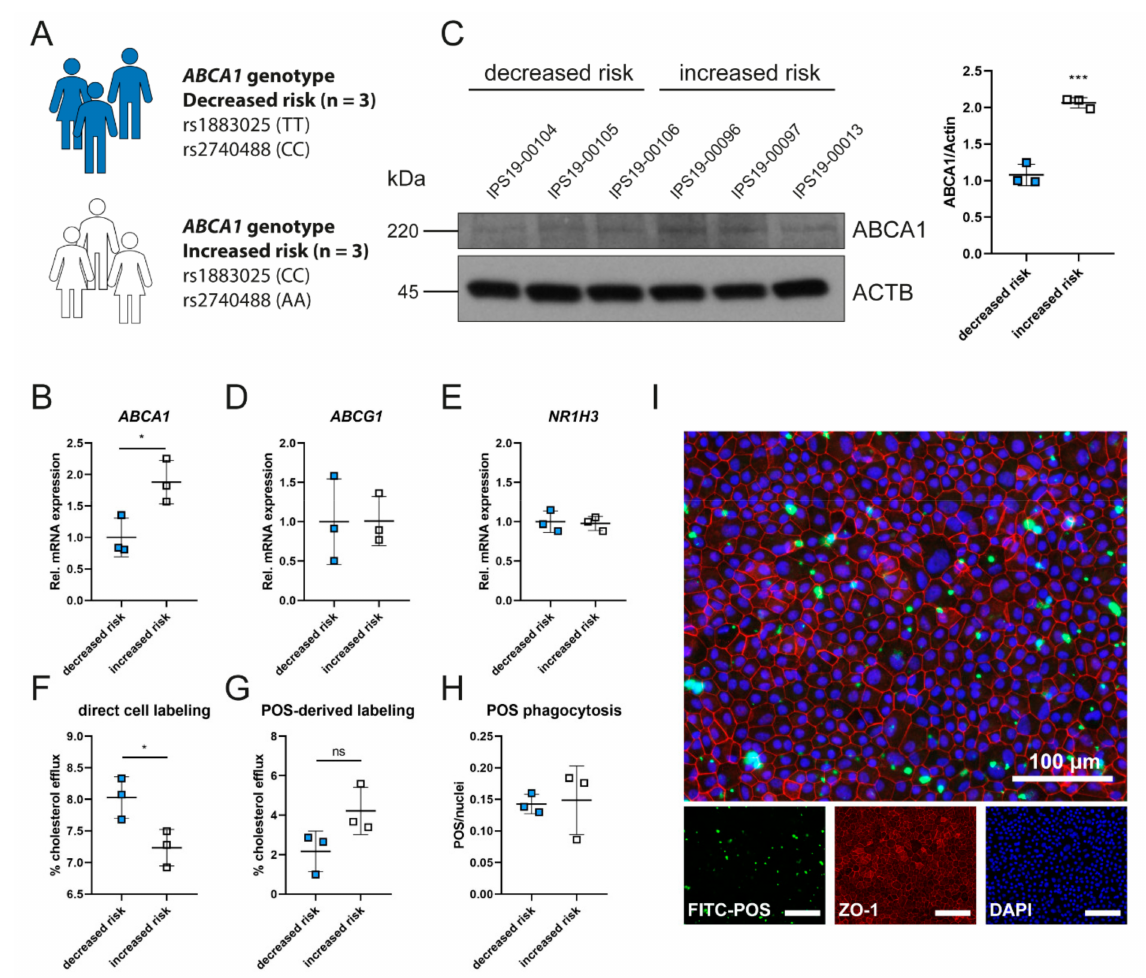
Figure 2. Basal ABCA1 expression and function in patient-derived iRPEs. ( A ) Representation of patient-derived iPSC lines and genotypes harboring polymorphisms in ABCA1 that are associ- ated with decreased or increased risk for AMD development. ( B ) Relative expression of ABCA1 mRNA in patient-derived iRPEs under basal conditions normalized to RPL28 and decreased risk group. ( C ) Western blot analysis of ABCA1 levels in patient-derived iRPEs under basal conditions. Actin was detected as loading control. ABCA1 expression was quantified and normalized to actin. ( D , E ) Relative expression of ABCG1 ( D ) and NR1H3 ( E ) mRNA in patient-derived iRPEs under basal conditions normalized to RPL28 and decreased risk group. ( F ) Cholesterol efflux in patient-derived iRPEs after direct cell labeling and in the presence of ApoAI. ( G ) Cholesterol efflux in patient- derived iRPEs after phagocytosis of BODIPY-cholesterol-loaded POSs and in the presence of ApoAI. ( H ) Quantification of phagocytosed POSs per nuclei in patient-derived iRPEs. Values shown are means ± SD (n = 3). * p < 0.05; *** p < 0.001. Unpaired Student’s t -test. ( I ) Representative fluorescence microscopy images of phagocytosed FITC-labeled POSs (green) and staining for ZO-1 (red) and DAPI (blue) of increased risk cell line IPS19-00096. Scale bar = 100 µ